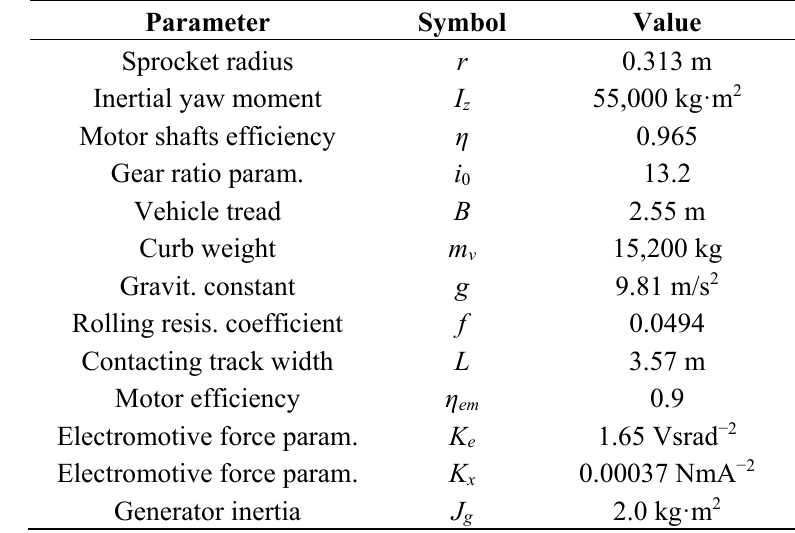
Figure 1. Powertrain configuration of the HETV. Table 1. HETV